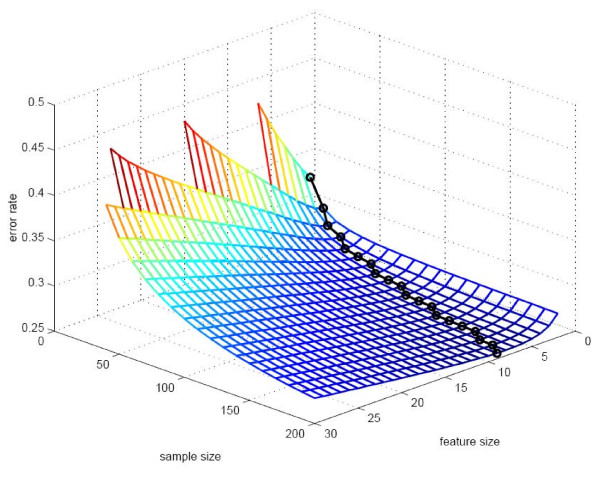
Peaking phenomenon for LDA with highly correlated features.